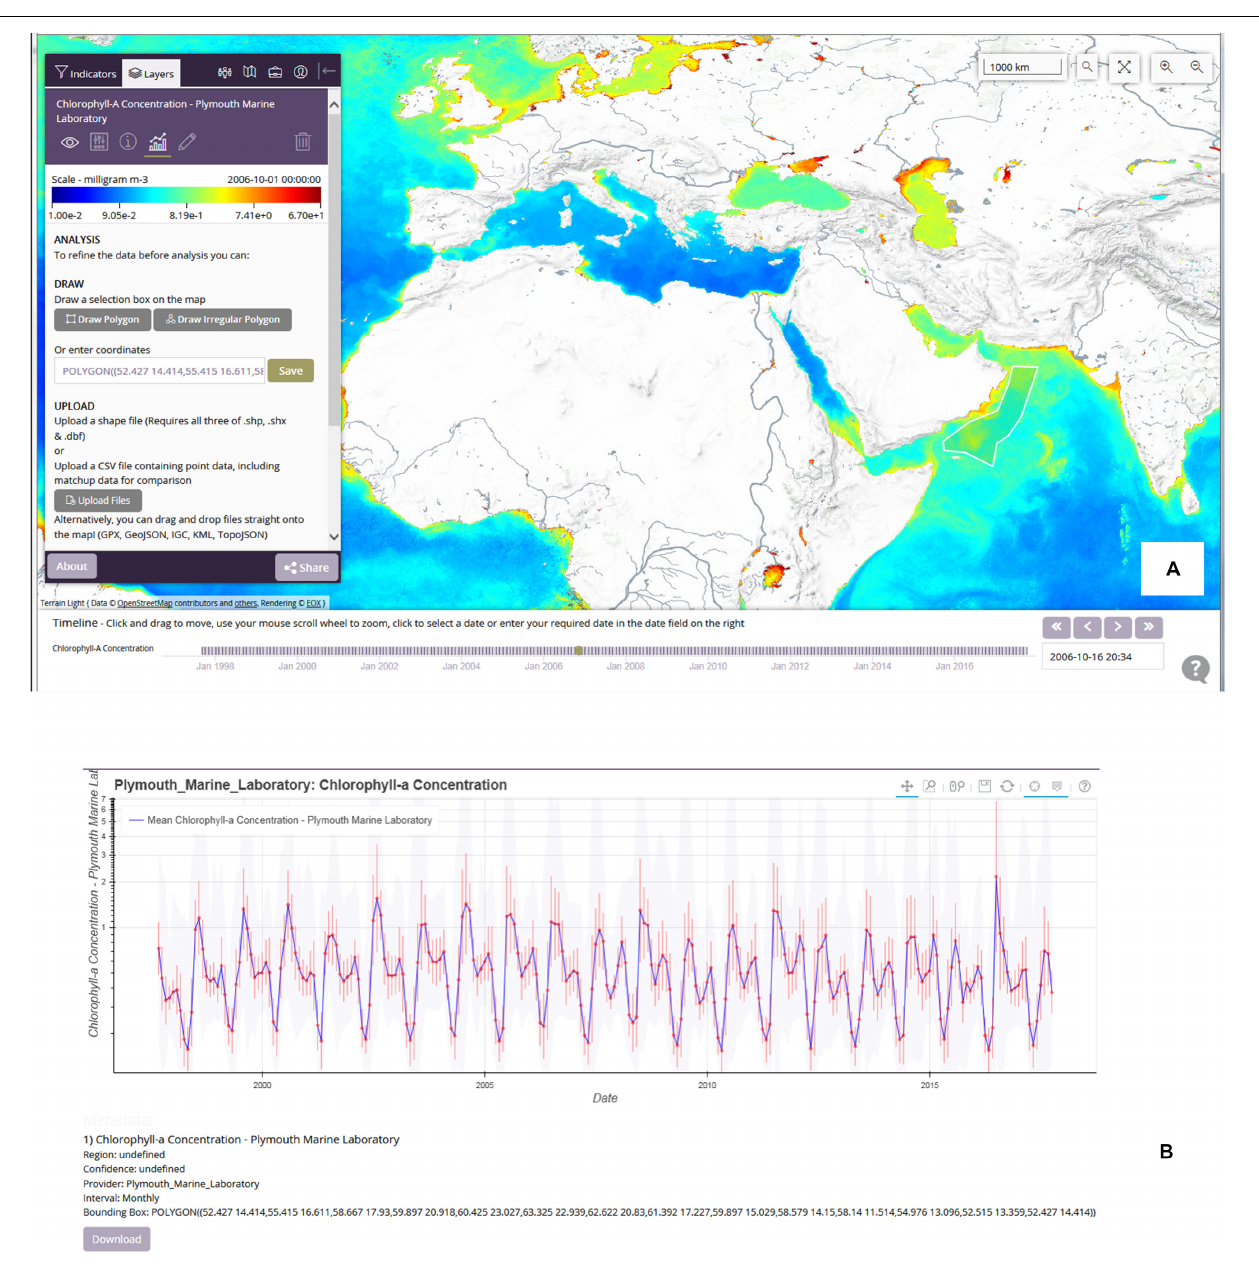
FIGURE 2 | Screenshots for ESA ocean colour CCI OGC-compliant visualisation/analysis portal: (A) monthly version 3.1 global chl-a map (comprising merged bias-corrected SeaWiFS, Aqua-MODIS, MERIS and VIIRS) with uploaded shapefile for image data extraction. (B) Time series plot for region of interest; vertical bars show standard deviation and background grey shows